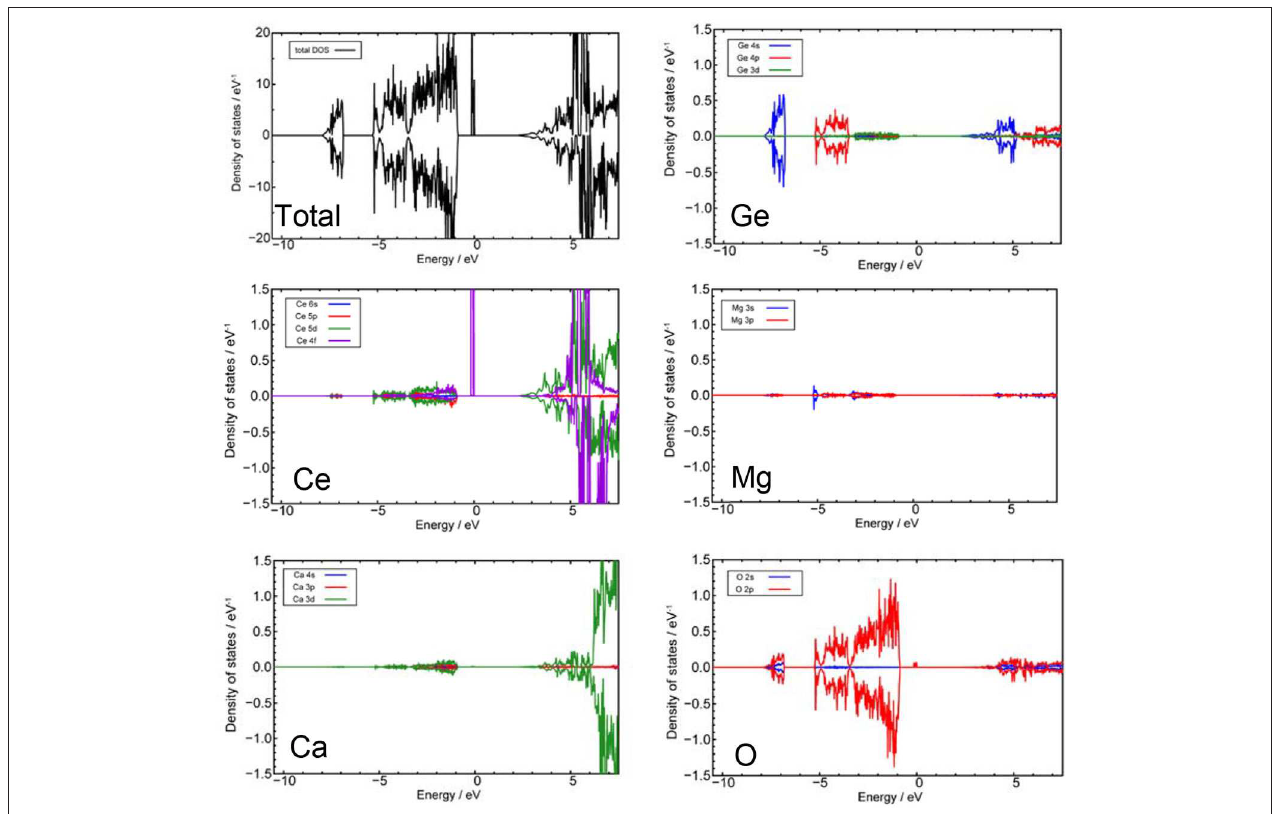
FIGURE 7 | Total and projected partial density of states calculated from the model shown in Figure 6 . The energy level of a valence band top is set to be 0eV on the horizontal axes. Positive and negative values of the vertical axes indicate the DOS of up-spin and down-spin, respectively. Blue, red, green, and purple lines indicate the s , p , d , and f orbitals of each element,